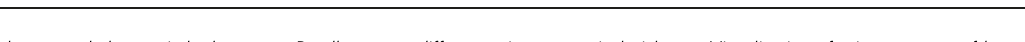
Fig. 4 Marginal zone and class switched memory B cells occupy different microanatomical niches. a Visualisation of microanatomy of human appendix by imaging mass cytometry. A representative example of appendix from three different donors studied. CD3 (T cells; green), CD20 (B cells; magenta), CD86 (dendritic cells; cyan) and keratin (epithelium; red). Scale bar represents 100 μ m. b Conventional mixing of fl uorochromes did not enable the identi fi cation of B cell subsets that require multiple markers. The combination of CD27 (green), CD45RB (blue), CD20 (magenta) and IgD (cyan) would require the further addition of IgM for the detection of marginal zone B cells and their putative precursors. c Pixels with signal representing CD19 + CD20 + CD27 + IgM + IgD + of MZ B cells are green (approximate population boundary marked with a green dotted line). Pixels with signal representing CD19 + CD20 + CD27 + IgM − IgD − class switched memory (CSM) cells are magenta (approximate population boundary marked with a magenta dotted line). Importantly, pixels representing MZ